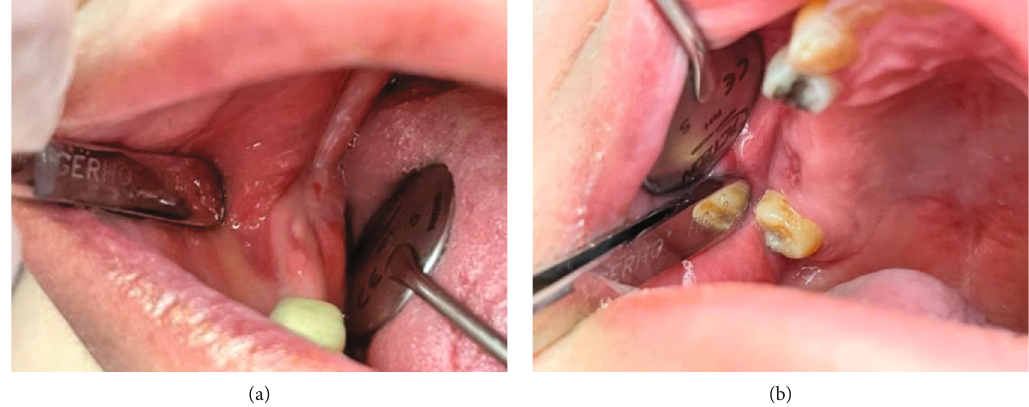
Figure 10: (a, b) Final intraoral photos: after extraction site of 4.7 (a); after extraction site of 1.7 (b). Good tissue healing on the extraction sites of 4.7 (blue arrow) and 1.7 (green arrow).